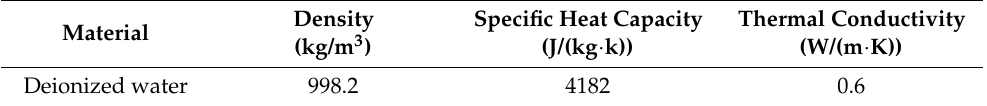
Figure 2. When the number of grids tends to 684,884, the highest temperature of